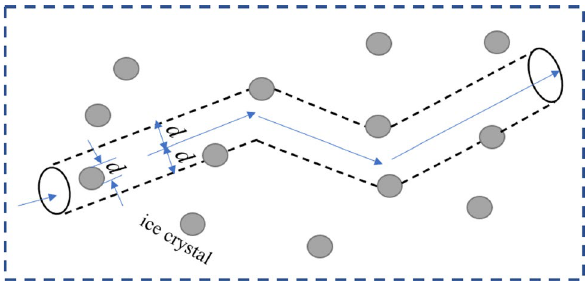
Figure 1. Schematic diagram of the collision zone between ice